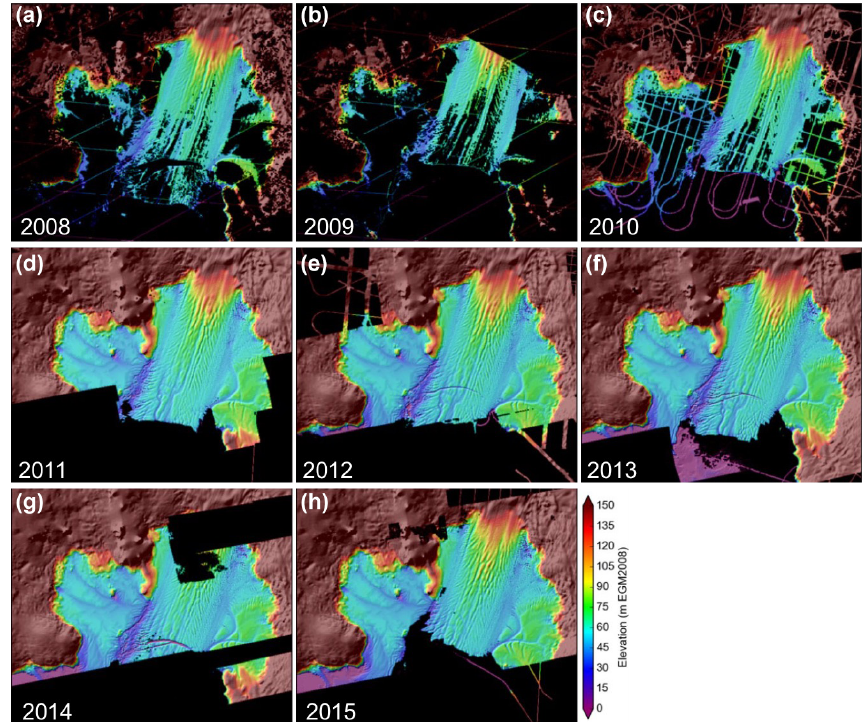
Figure 6. Annual DEM composites using all available elevation data. The primary DEM sources are SPIRIT (a–c) and World- View/GeoEye (d–h)